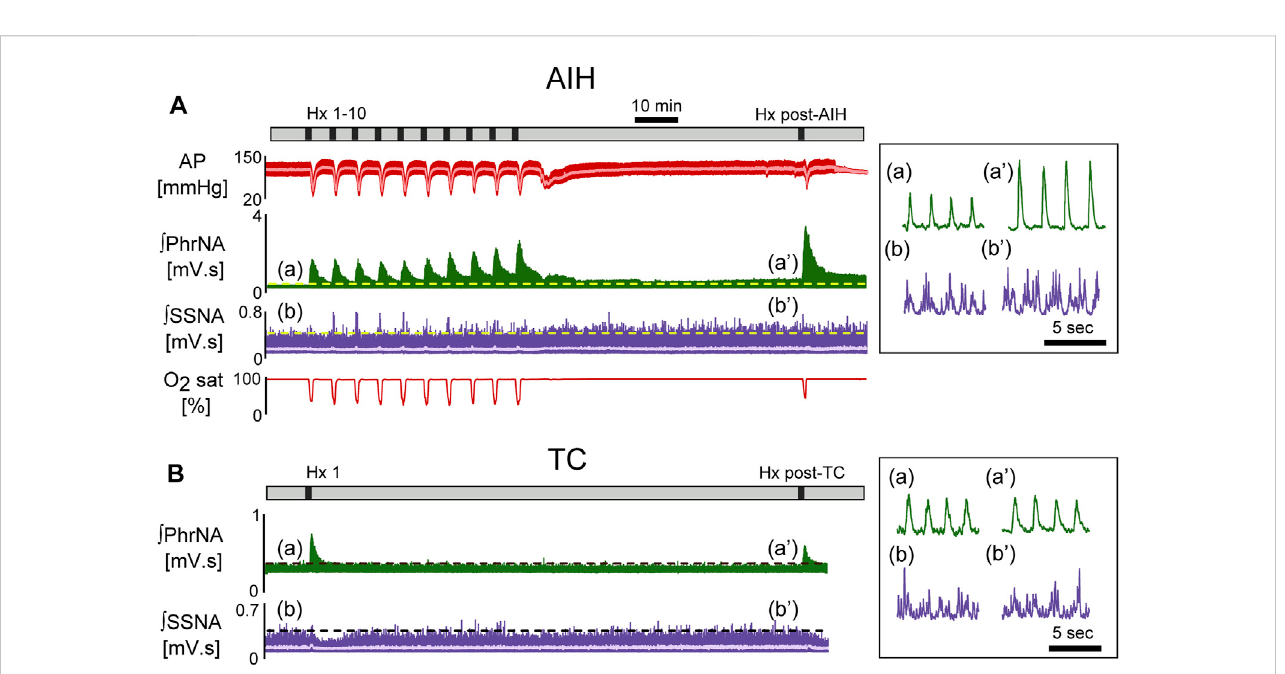
FIGURE 2 Representative recording of AP (red, MAP superimposed in light color), integrated phrenic ( ʃ PhrNA, green), integrated splanchnic sympathetic nerve activity ( ʃ SSNA, purple; mean in light purple) and O 2 saturation (red) in response to repeated hypoxia. (A) AIH, Hx 1 – 10 and Hx post-AIH. (B) time control (TC). Black bars in time lines indicate periods of hypoxia. Horizontal dashed lines in traces indicate baseline PhrNA and SSNA. Insets on the right show an expanded time scale of ʃ PhrNA and ʃ SSNA before (a, b) and 1 h after AIH or TC (a ’ , b ’